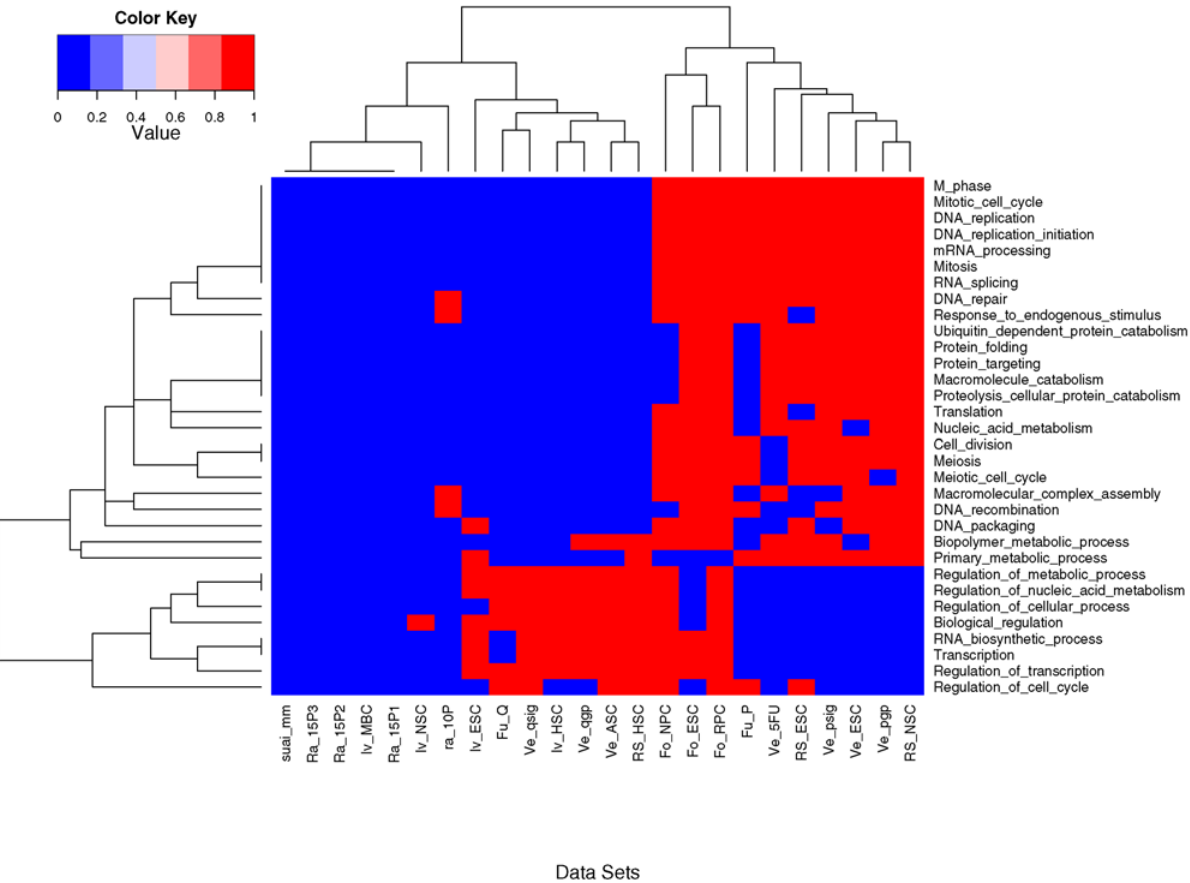
Figure 5. The over-represented GO terms in up-regulated genes of mouse SCs are shown. A heat map showing dendograms clustering the GO terms (x-axis) associated with the different SC data sets (y-axis). The dendogram on the x-axis shows clusters of the various data sets into three main categories. The cluster on the left (x-axis) comprises the negative controls, the cluster in the middle contains the adult SCs and the quiescent adult SCs and the third cluster on the right (of x-axis) largely contains the embryonic and the proliferating adult SCs. The key to the abbreviations follow: RS-Ramalho-Santos; Ve-Venezia; Fo-Fortunel; Iv-Ivanova; Ra-Random_mgu74av2; Fu-Fukada. The GO term identifiers are given in Table 12 .